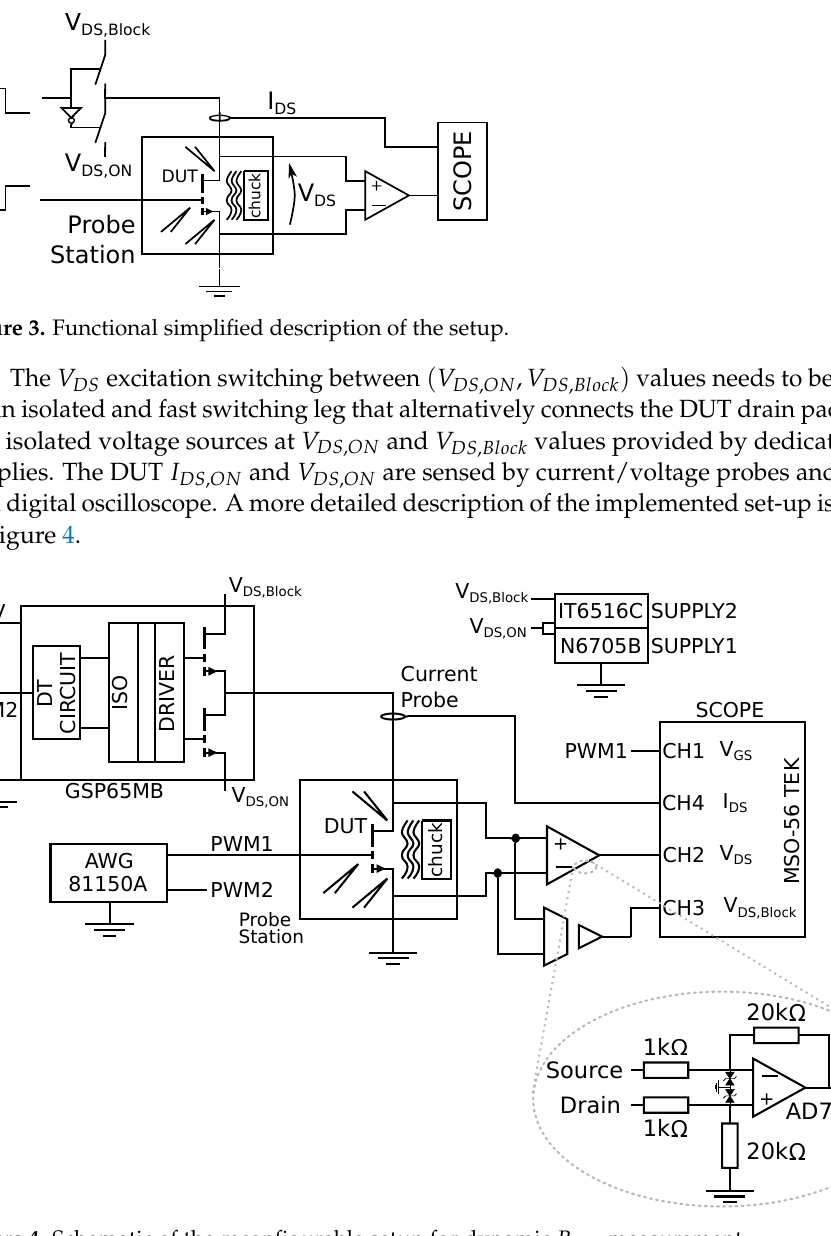
Figure 4. Schematic of the reconfigurable setup for dynamic R ON